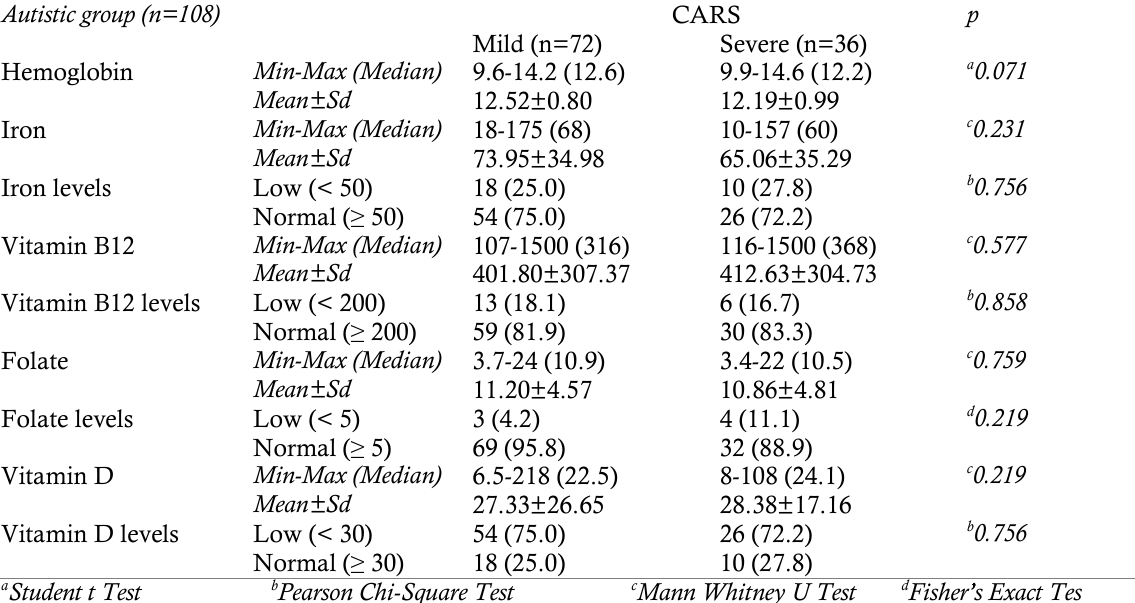
Table 7. Evaluation of Vitamin and Mineral Measurements by CARS Levels